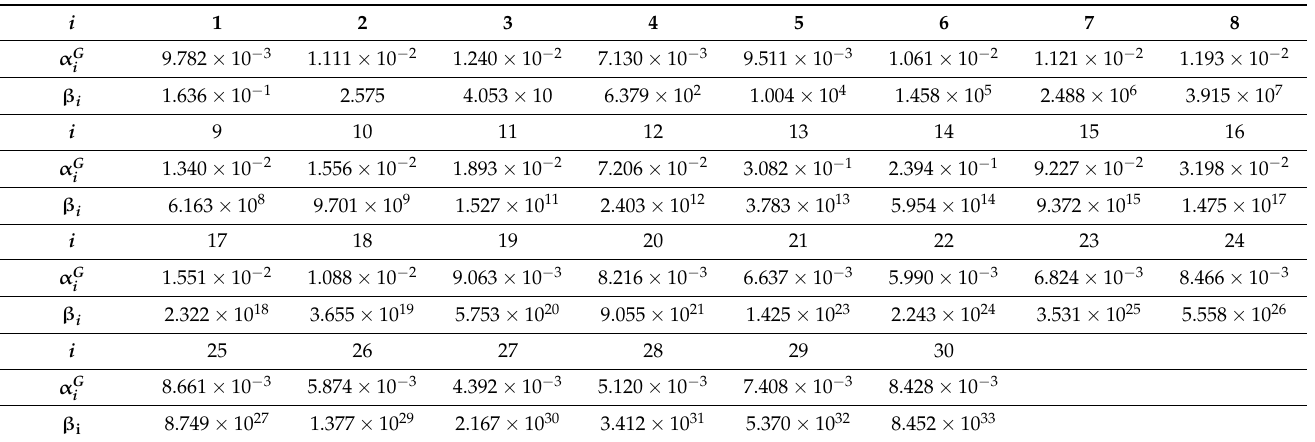
Table 10. Values of viscoelastic constants of the relaxation function for 30 relaxation times.